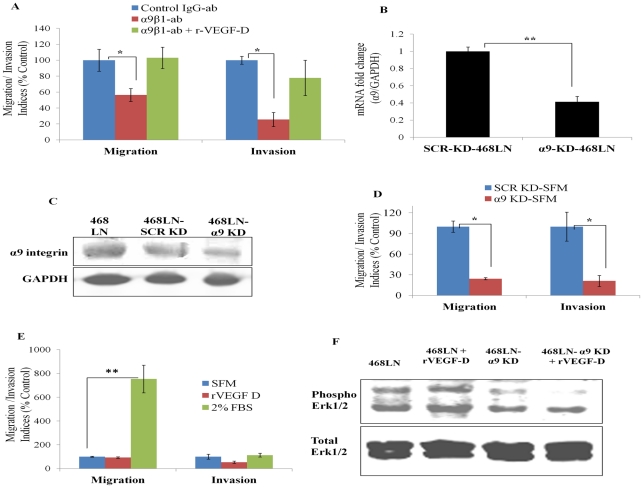
Blockade of α9β1/VEGF-D interaction hinders autocrine migratory/invasive functions of 468LN cells and α9-associated signaling:(A) A strong inhibition of both migration and invasion indices of 468LN cells, noted with α9β1 blocking antibody (5 µg/ml). This inhibition could not be reversed by addition of rVEGF-D. Data were normalized to control IgG for α9β1 blocking antibody (ab) and to α9β1 blocking antibody treated cells for rVEGF-D. Knock down of α9 was validated with qRT-PCR (B) and western blot (C). (D) Knock down of α9 integrin (α9-KD) significantly compromised both migration and invasion of 468LN cells compared to scrambled knock down (SCR-KD) cells. (E) Following α9-KD, but not SCR-KD, migratory and invasive functions could be stimulated with FBS, but not with rVEGF-D. Data presented as the mean (n = 4 except invasion data in D, n = 6) ± SE. *, P<0.05; **,P<0.01. (F) Phospho Erk1/2 was measured using western blots in wild type and α9-silenced, serum starved (24 h) 468LN cells in the presence or absence of rVEGF-D (3 µg/ml) at 0–60 min as compared to total Erk1/2. Significant constitutive Erk1/2 activity noted in the absence of rVEGF-D was stimulated further in the presence of rVEGF-D at 15–45 min (peak shown at 45 min). Knock down of α9 integrin resulted in suppressed Erk1/2 activity in both cases.